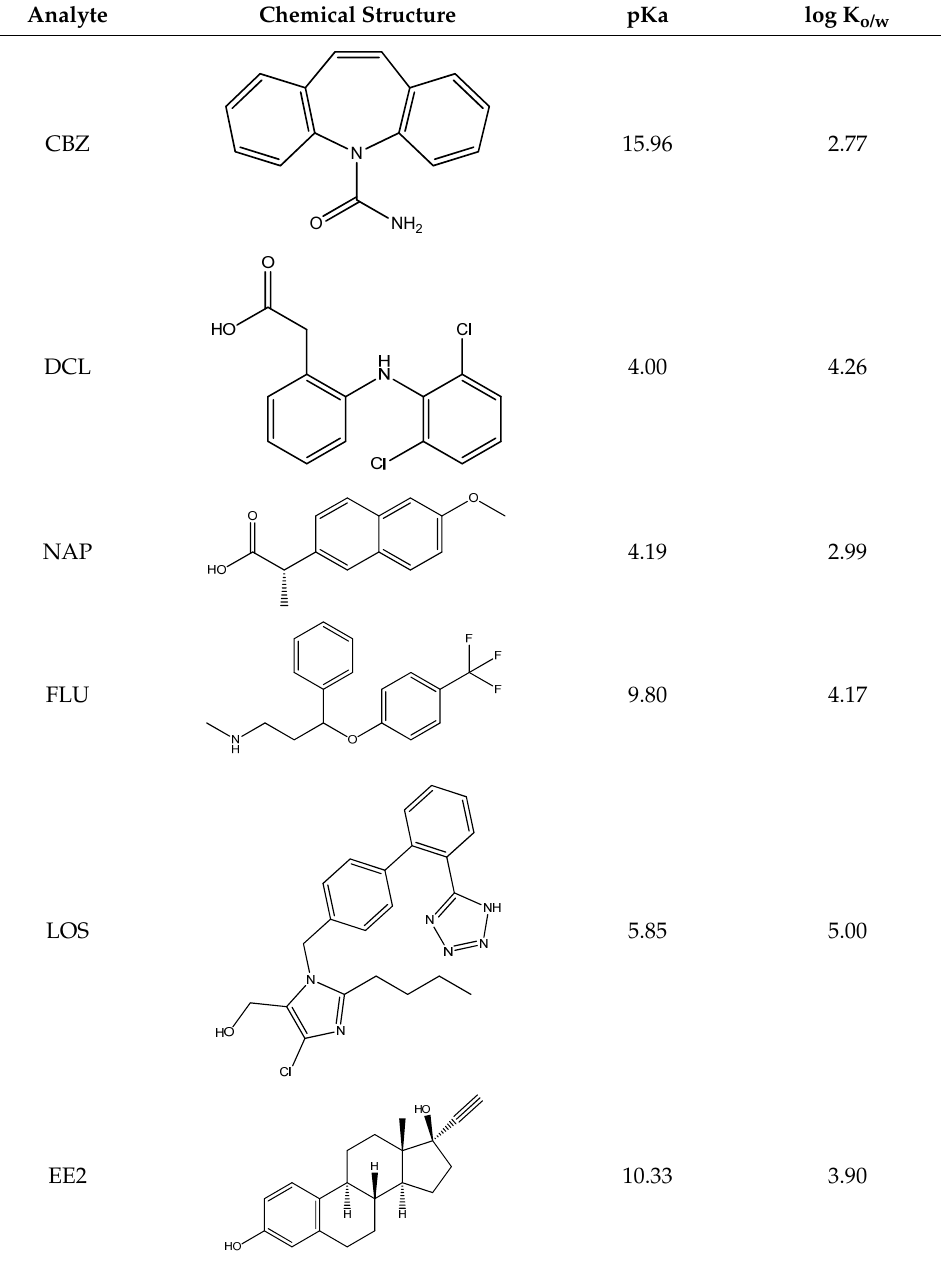
Table 1. Chemical structures and some physicochemical properties of the analytes (ChemAxon).